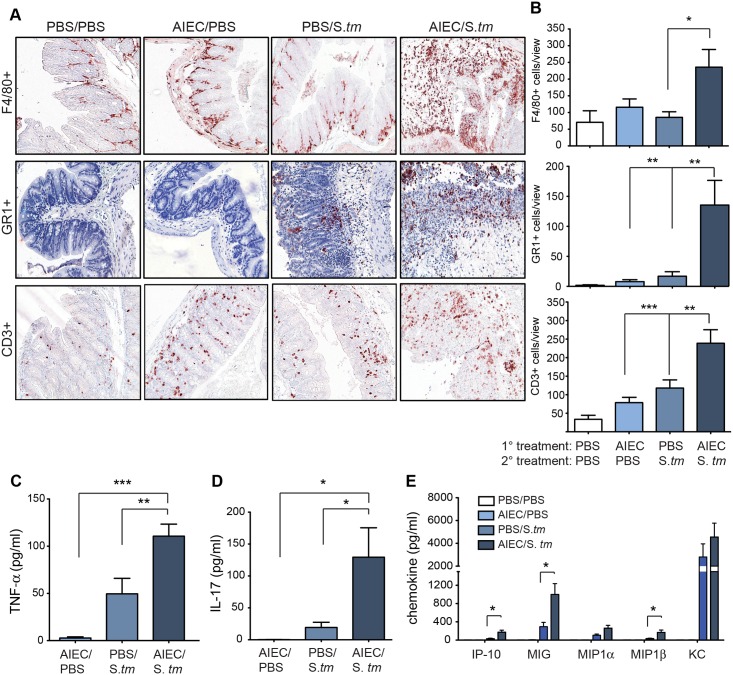
Prior AIEC colonization leads to heightened cellular and proinflammatory cytokine responses.(A) Immunohistochemical staining of cecal tissue for F4/80+, GR1+, and CD3+ cells. Each image is representative of 2 independent experiments with 5 mice per group. Original magnification 200x. (B) Quantification of immunohistochemical staining. Data is from 6–8 views per section from 5 mice. *p<0.05, **p<0.01, ***p<0.001(Mann-Whitney test). (C) TNF-α, (D) IL-17 and (E) chemokines were measured using ELISA from supernatants after overnight incubation of explanted ceca. Data are the means ± SEM of 5 mice per group from 3 separate experiments. *p<0.05, **p<0.01, ***p<0.001 (one way ANOVA with Tukey for comparisons between groups).